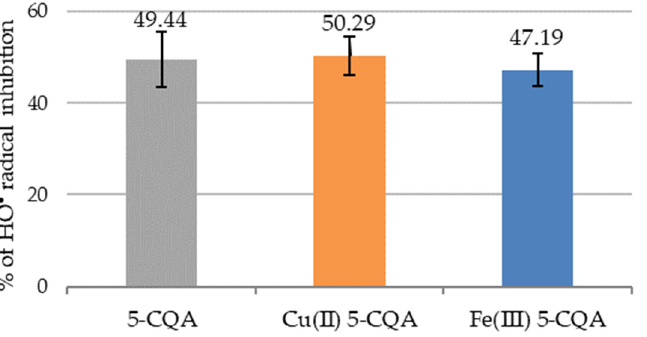
Figure 10. Antioxidant properties of 5-CQA, Cu(II) 5-CQA, and Fe(III) 5-CQA (0.1 mM) expressed as the ability to scavenge HO • radicals (%I). Mean values from three independent experiments ± SDs are shown. There were no significant statistical differences between particular compounds (Tukey’s test, p < 0.05).